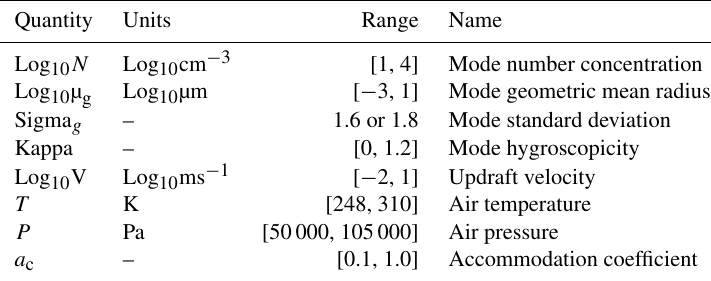
Table 1. Pyrcel parcel model input parameters and sampling range used for emulator